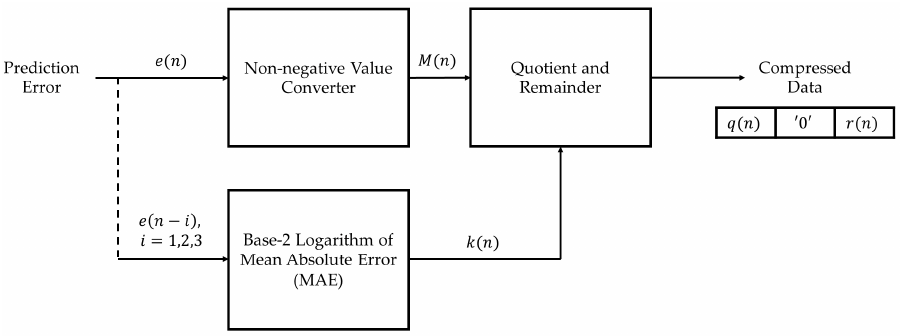
Figure 4. Block diagram of the modified Golomb–Rice coding.